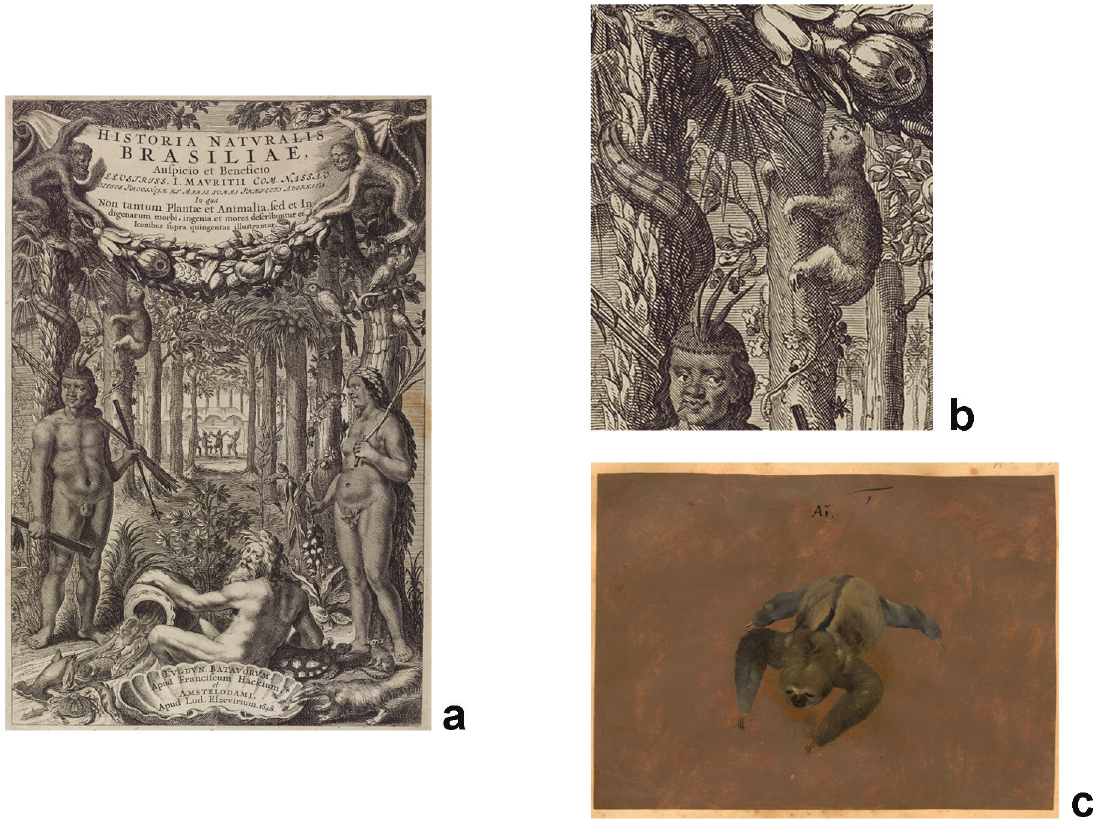
Figure 4 - (a) Frontispiece of Historia Naturalis Brasiliae by Willem Piso and George Marcgrave (1648) with decorative elements, including animals like the sloth. Courtesy of the John Carter Brown Library at Brown University. (b) The image of sloth represents the brown throated sloth Bradypus variegatus , a possibly drawing by George Marcgrave published originally in Libri Principis (‘Handbook’ I fol. 30r, Libri Picturati A36), compiled around 1640. (c) The brown throated sloth Bradypus variegatus . Possibly drawing of Albert Eckhout in Theatrum rerum naturalium Brasiliae ( Libri Picturati A 34) (1660 – 1664). Copyritght: Jagiellonian Library,